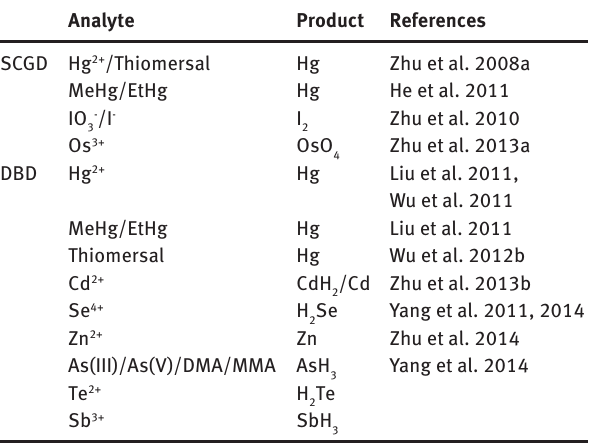
Table 1 Possible products of SCGD- and DBD-induced vapor gen- eration for several element